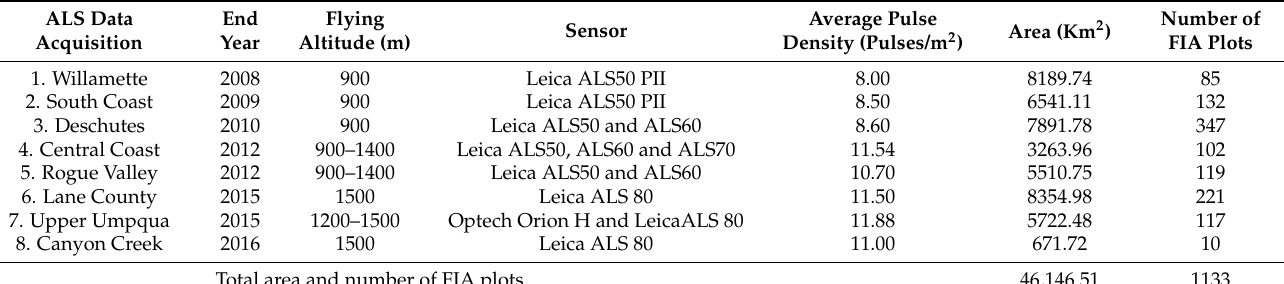
Table 1. ALS data acquisitions summary and number of field plots per ALS acquisition.